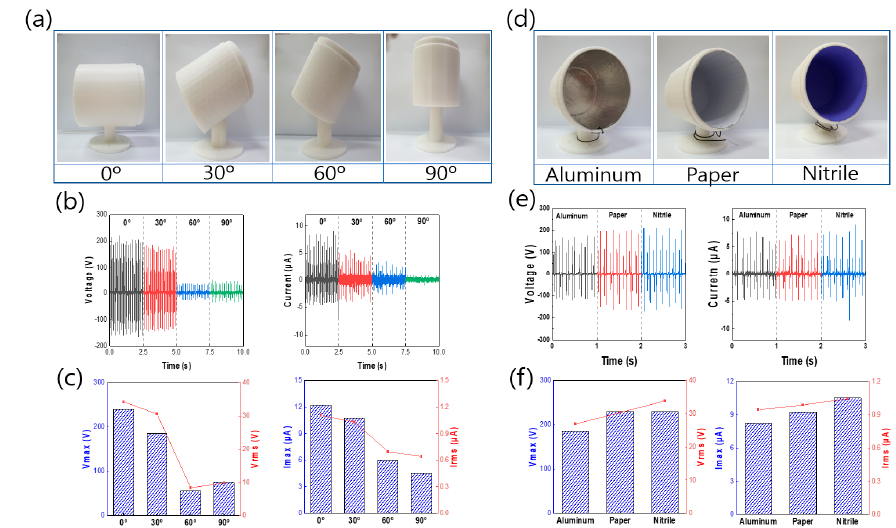
Figure 6. ( a ) Photographs showing the angles of the TENG cylinders; ( b , c ) plots of V max , V rms , I max , and I rms according to the cylinder angles; ( d ) photographs of the types of positively charged electrical materials on the TENG interior surfaces; and ( e , f ) plots of V max , V rms , I max , and I rms values according to the type of positively charged electrical materials.